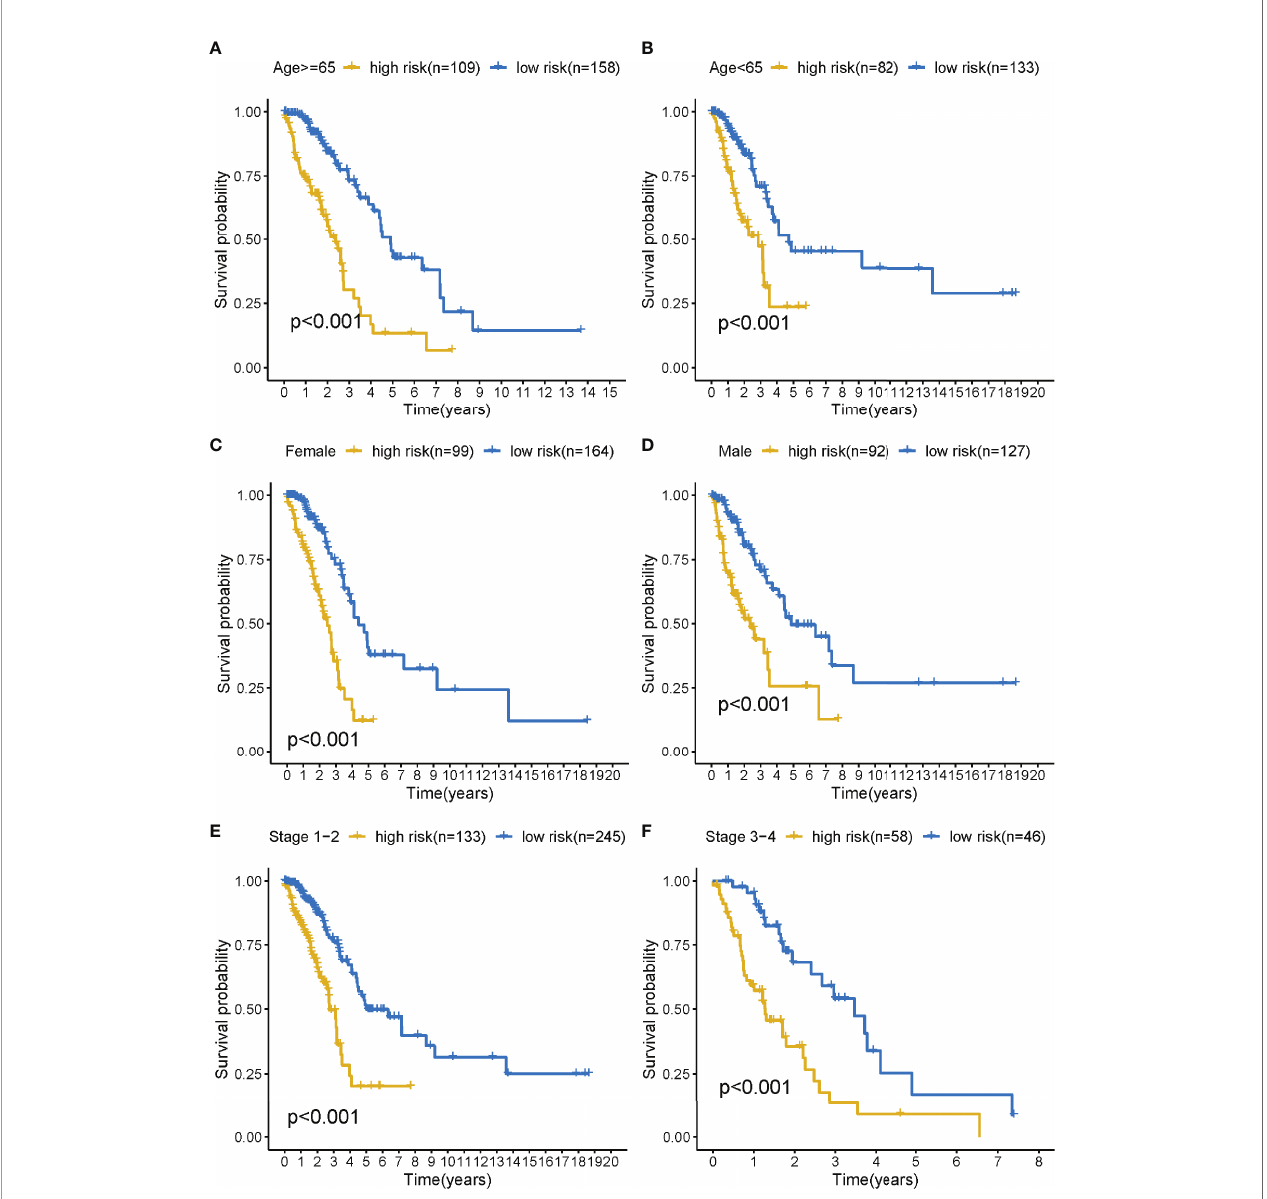
FIGURE 5 | The survival curves of the LMR-lncRNA signature strati fi ed by age, gender, and stage. (A) ≥ 65 years, (B) <65 years, (C) female, (D) male, (E) stage 1-2, and (F) stage